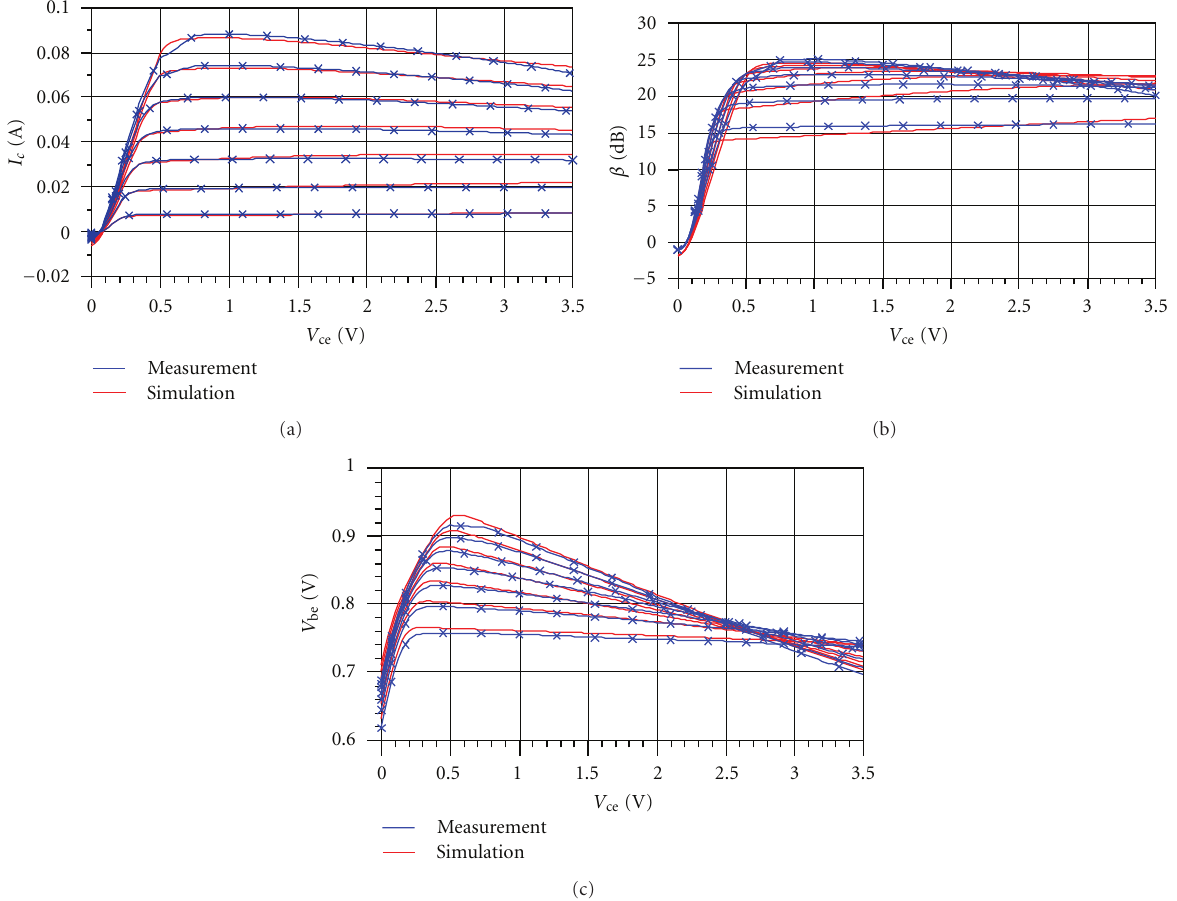
Figure 4: Comparison between model (red) and I(V) measurement (blue cross) with I b current ranging 0.5 to 3.5mA and a V ce voltage ranging 0 to 3.5V for a temperature equal to 25 ◦